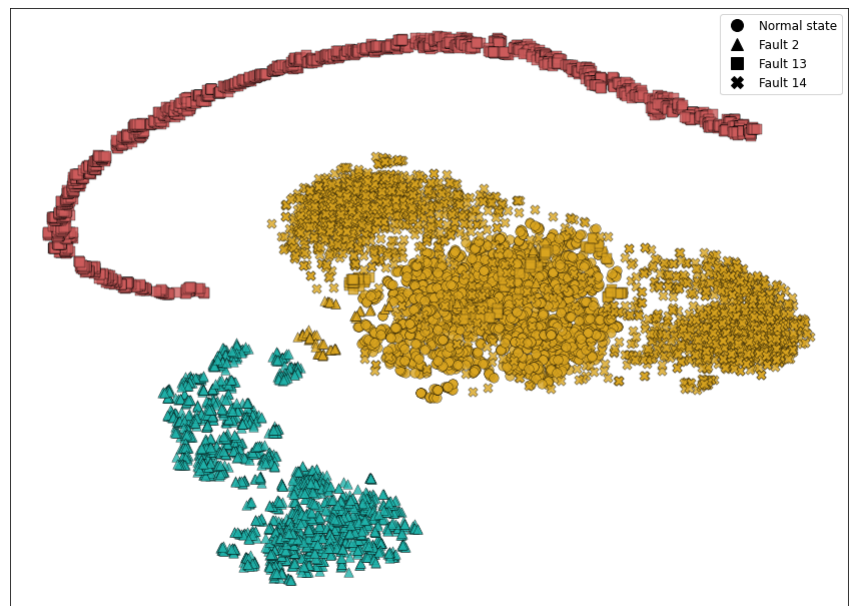
Figure 9. Hierarchical clustering of the TEP data set with t-SNE dimension